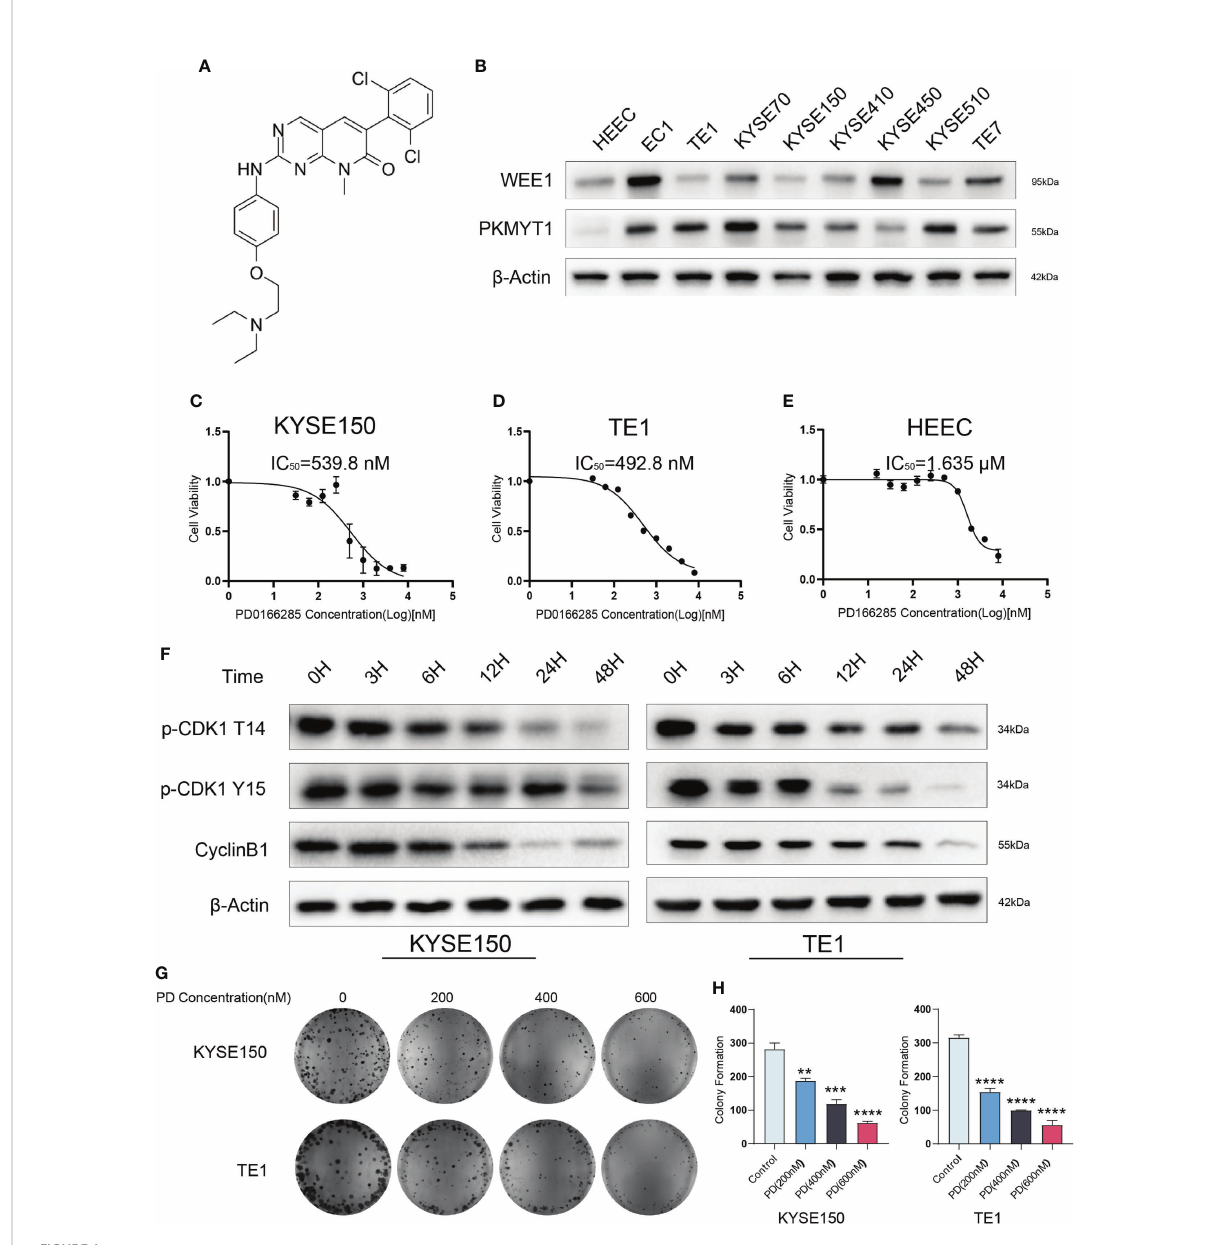
FIGURE 1 PD0166285 is effective in ESCC cells. (A) The Structural formula of PD0166285. (B) The expression of WEE1 and PKMYT1 are upregulated in ESCC cells. (C – E) The IC 50 of PD in KYSE150, TE1 and HEEC cells. (F) PD inhibits WEE1 and PKMYT1 in a time-dependent manner. (G, H) The clonogenic assay shows PD inhibited cell proliferation. ** P < 0.01, *** P < 0.001, **** P <